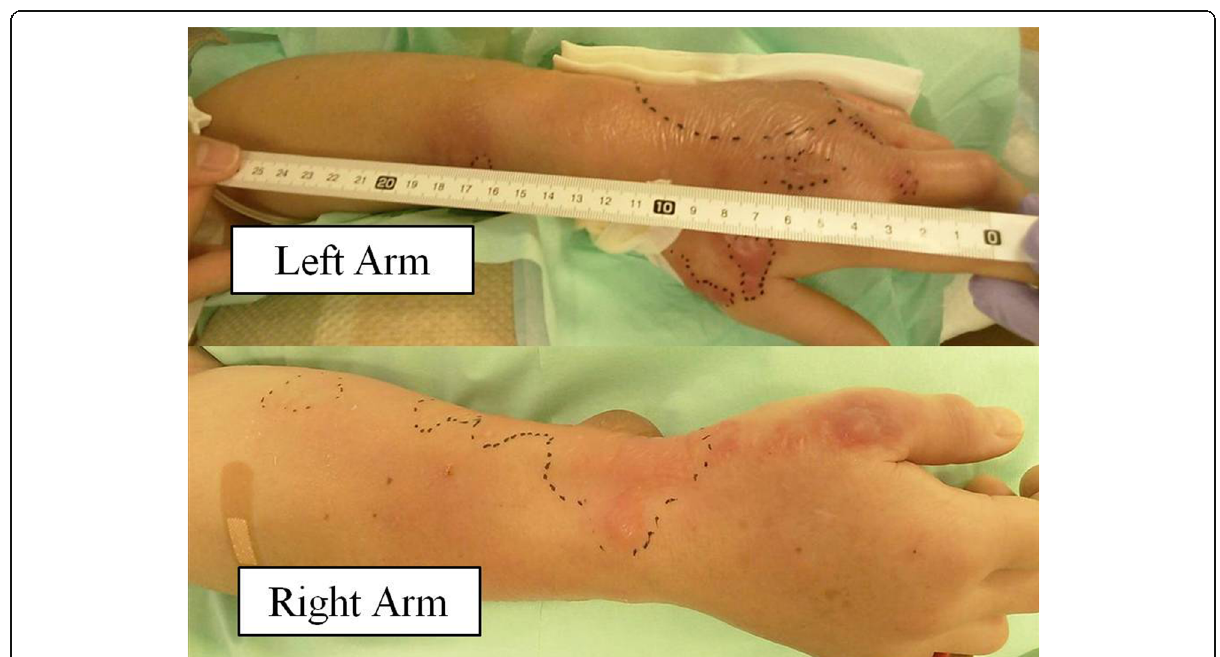
Fig. 3 The patient ’ s both arms on ICU day 2. Both arms developed swelling and redness on ICU day 2. Dashed line shows the range of